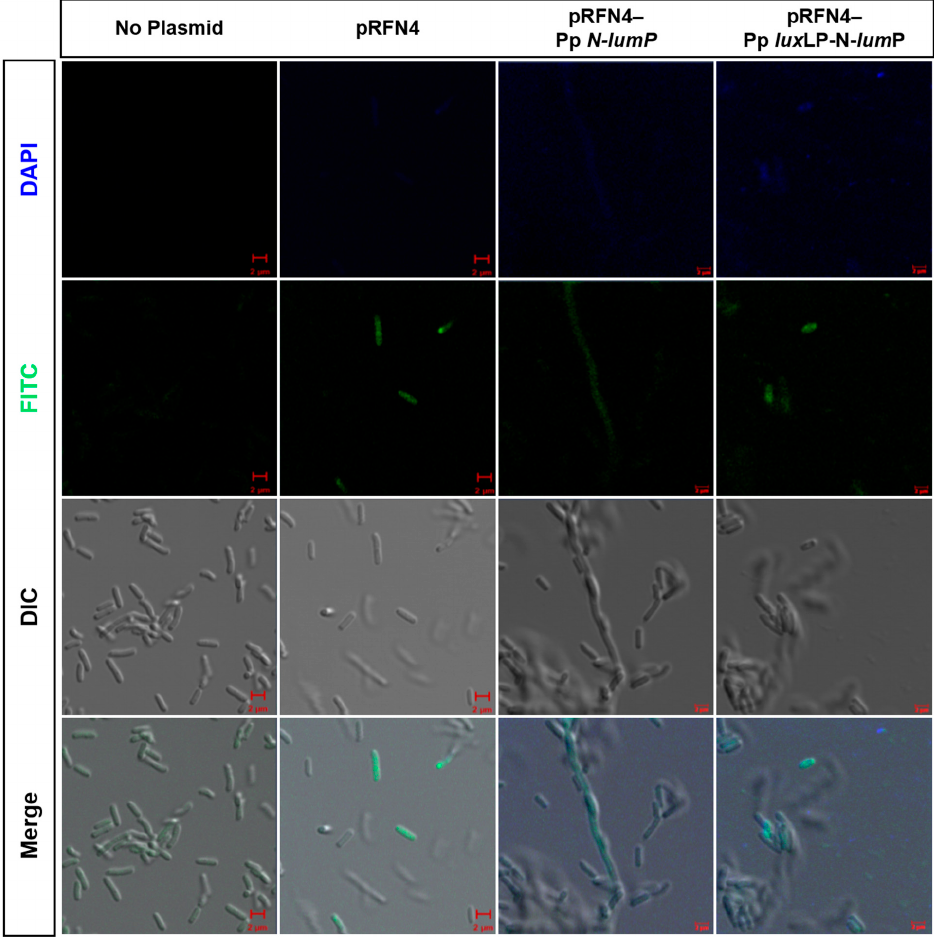
Figure 10. Fluorescence microscopic images of E. coli 43R containing the recombinant plasmids of pRFN4. E. coli 43R itself (No plasmid), transformed with pRFN4, with pRFN4-Pp N- lum P, and with pRFN4 Pp lux LP N- lum P. DAPI, Diamidino-2-phenylindol; FITC, Fluorescein isothiocynate; DIC, Differential interference contrast . Scale bar; 2 µm.